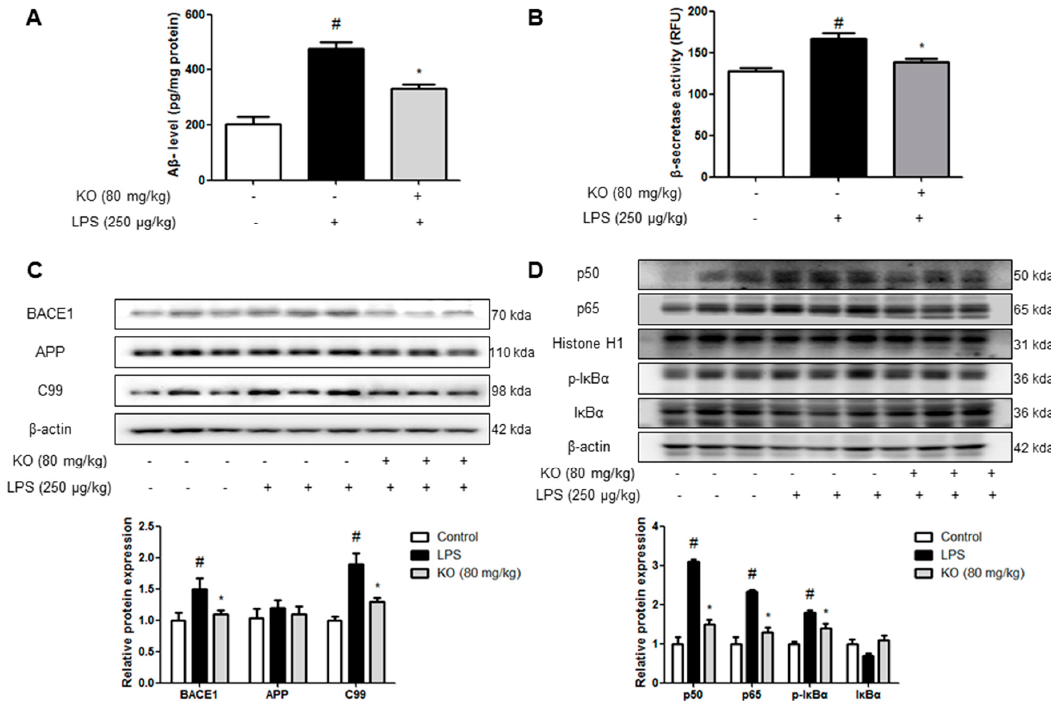
Figure 2. Effect of Krill oil on the LPS-induced amyloidogenesis and NF- κ B activity in mice brain. The levels of A β 1–42 in mice brain ( n = 5) were measured by ELISA ( A ). The activity of β -secretase in mice brain ( n = 5) was investigated using assay kit ( B ). The expression of APP, BACE1 and C99 were detected by Western blotting using specific antibodies in the mouse brain ( C ). Phosphorylation of I κ B, and p50 and p65 translocation were detected by Western blotting using specific antibodies in mice brain; β -actin and Histone H1 protein were used as an internal control ( D ). For the cropped images, samples were run in the same gels under same experimental conditions and processed in parallel. The graphs under Western blotting are the relative protein expression of three bands. Each band is representative of three experiments. Group differences were analyzed by one-way ANOVA followed by Bonferroni’s post-hoc analysis. # Significantly different from control group ( p < 0.05). * Significantly different from LPS-treated group ( p < 0.05).